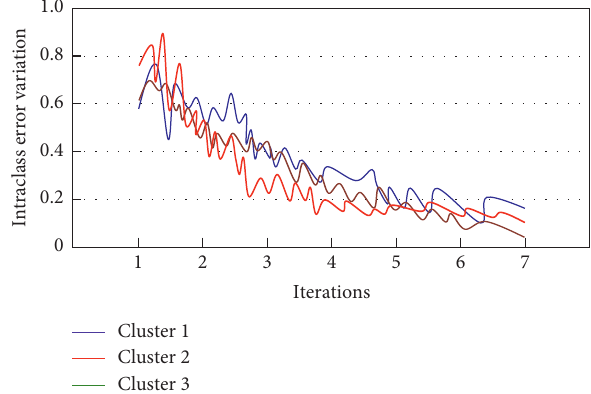
Figure 5: Variation of inner class error with iteration times in clustering process.